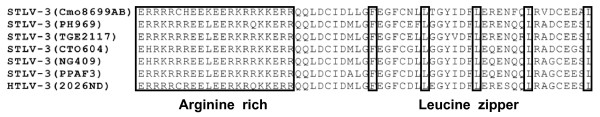
Conservation of the antisense protein (ASP) of STLV-3d(Cmo8699AB) and other prototypical PTLV-3s. Conserved arginine-rich region and potential leucine zipper motifs are indicated.